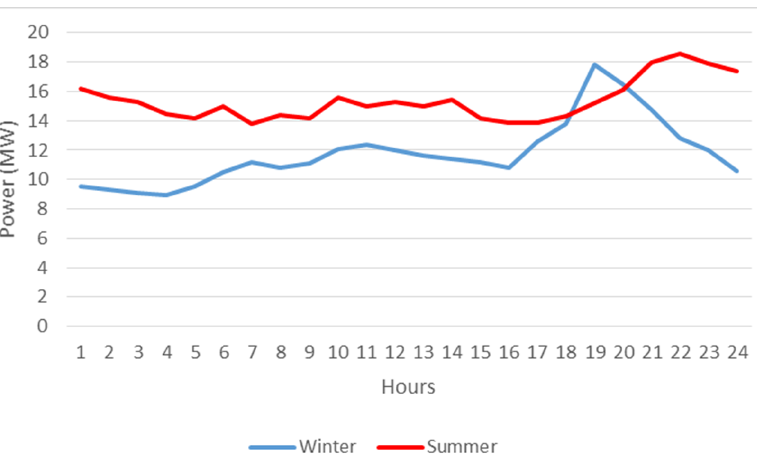
Figure 10. Demand behavior curves for a typical winter/summer day in 2019. Source: own elaboration with the model [27].